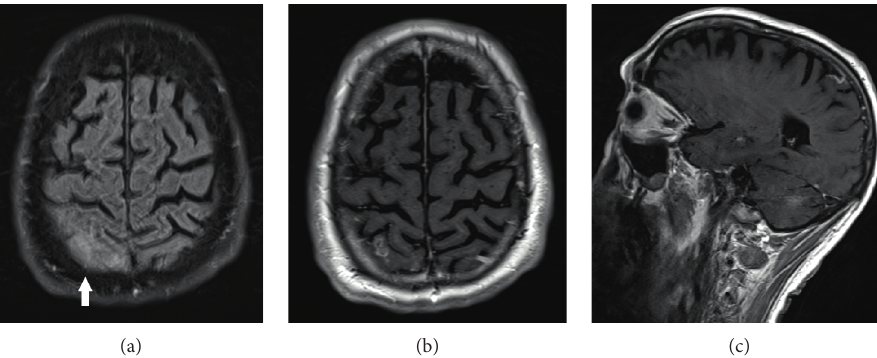
Figure 1: Fluid-attenuated inversion recovery images (FLAIR) showed a “dirty CSF” appearance in the right parietal region ((a), white arrow). Axial (b) and sagittal (c) T1-weighted images after the intravenous administration of gadolinium-chelate revealed a focal area of superficial contrast enhancement overlying the cerebral cortex, presumably representing a thickened pia